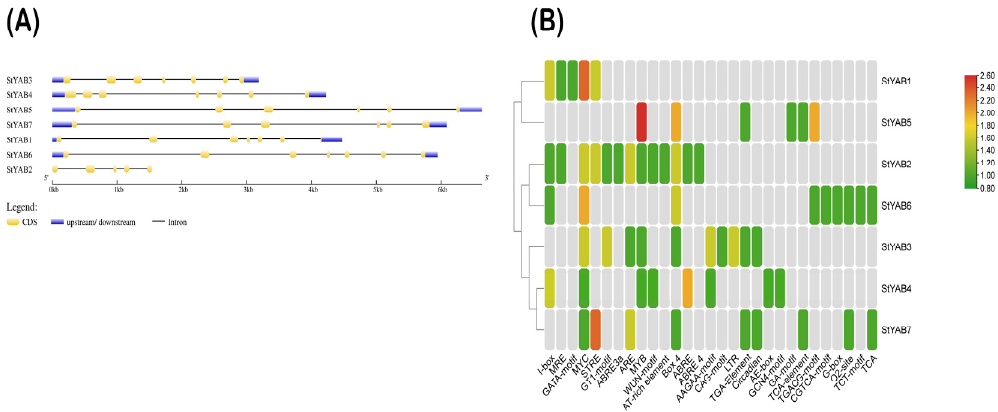
Figure 1. Predicted gene structures and cis-regulatory elements in StYAB. ( A ) Predicted gene structure of seven StYAB genes. The yellow regions show the exon regions, black lines show the introns, while the blue portions show the upstream/downstream sequences. ( B ) Cis -regulatory elements in putative StYAB promoters, which are associated with different plant developmental processes.